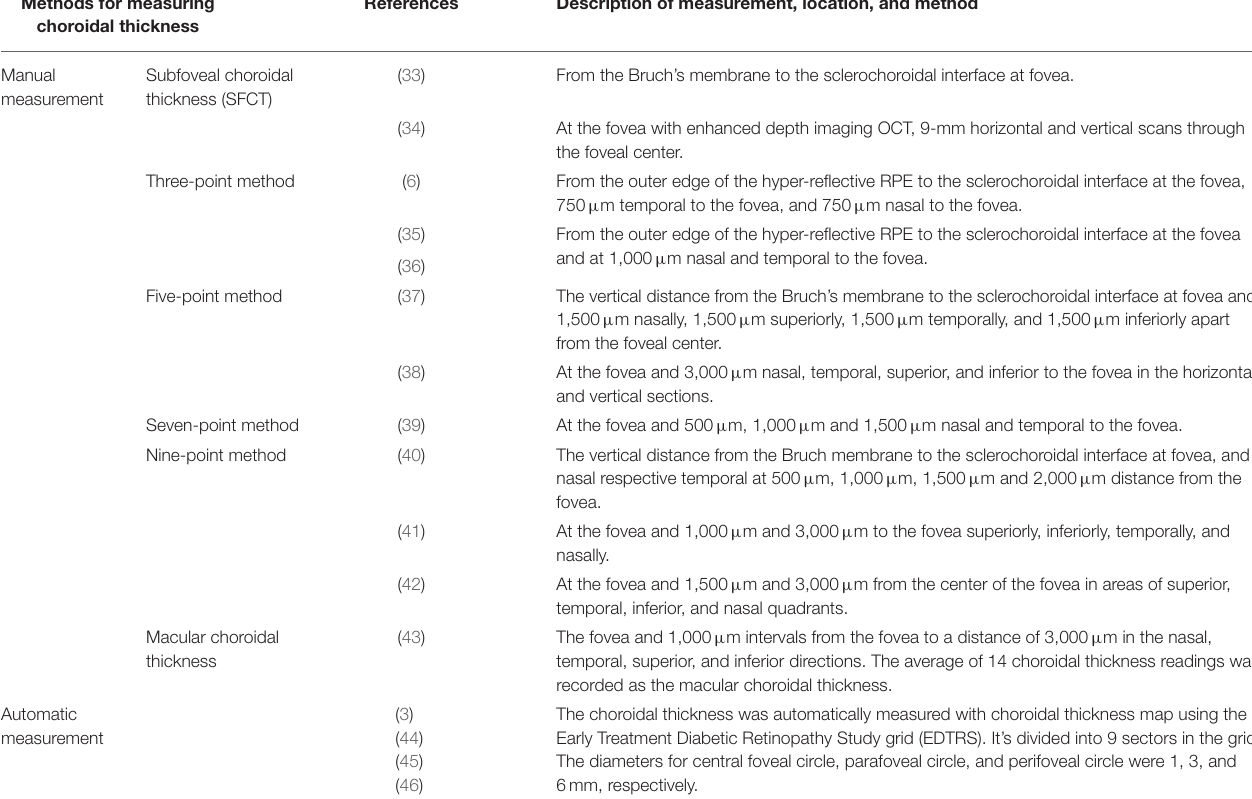
TABLE 1 | Methods for measuring choroidal